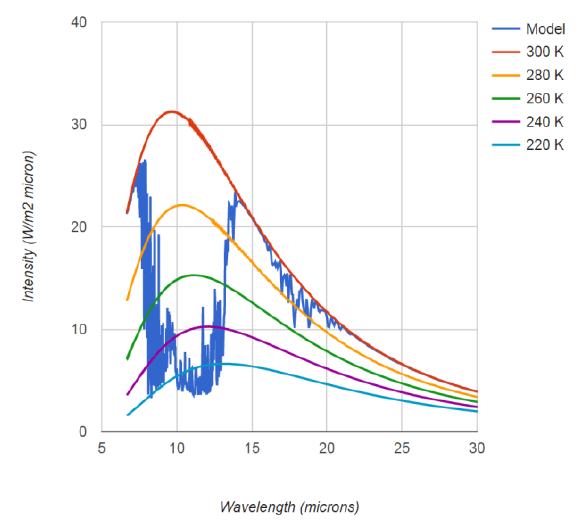
Fig. 3. Downwelling atmospheric infrared spectrum from the zenith, relative to that of a blackbody sky at 300 K. It was calculated using MODTRAN with a clear sky. An appropriately scaled similar modula- tion occurs for the other blackbody spectra shown [108].